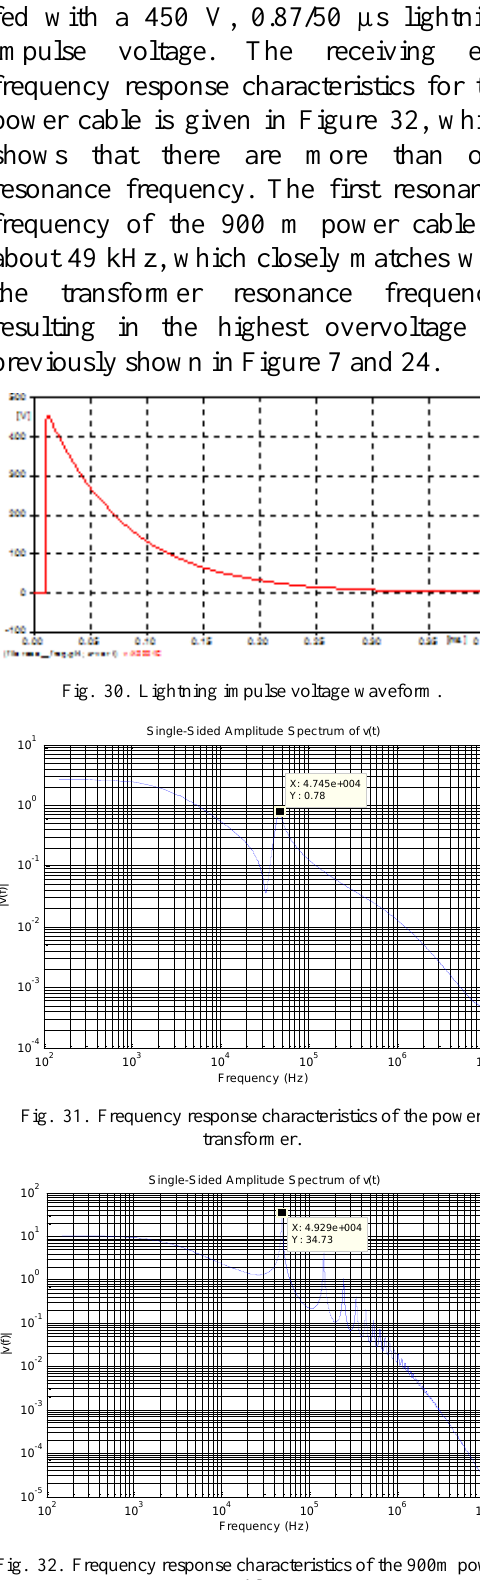
Fig. 32. Frequency response characteristics of the 900m power